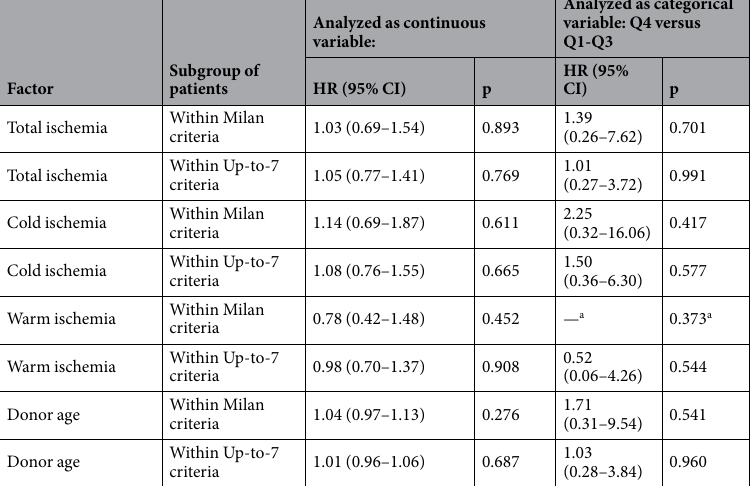
Table 7. Analyses of the associations between allograft ischemia and donor age and the risk of hepatocellular carcinoma recurrence after liver transplantation in patient within Milan and Up-to-7 criteria. Q4 – fourth quartile; Q1-Q3 – first to third quartile; HR – hazard ratio; 95% CI – 95% confidence interval. Hazard ratios for continuous variables are given per 1 log e (U/L) increase. Compared with log-rank test, 100% versus 89.4% recurrence free survival at 5 years in Q4 and Q1–Q3 patients,